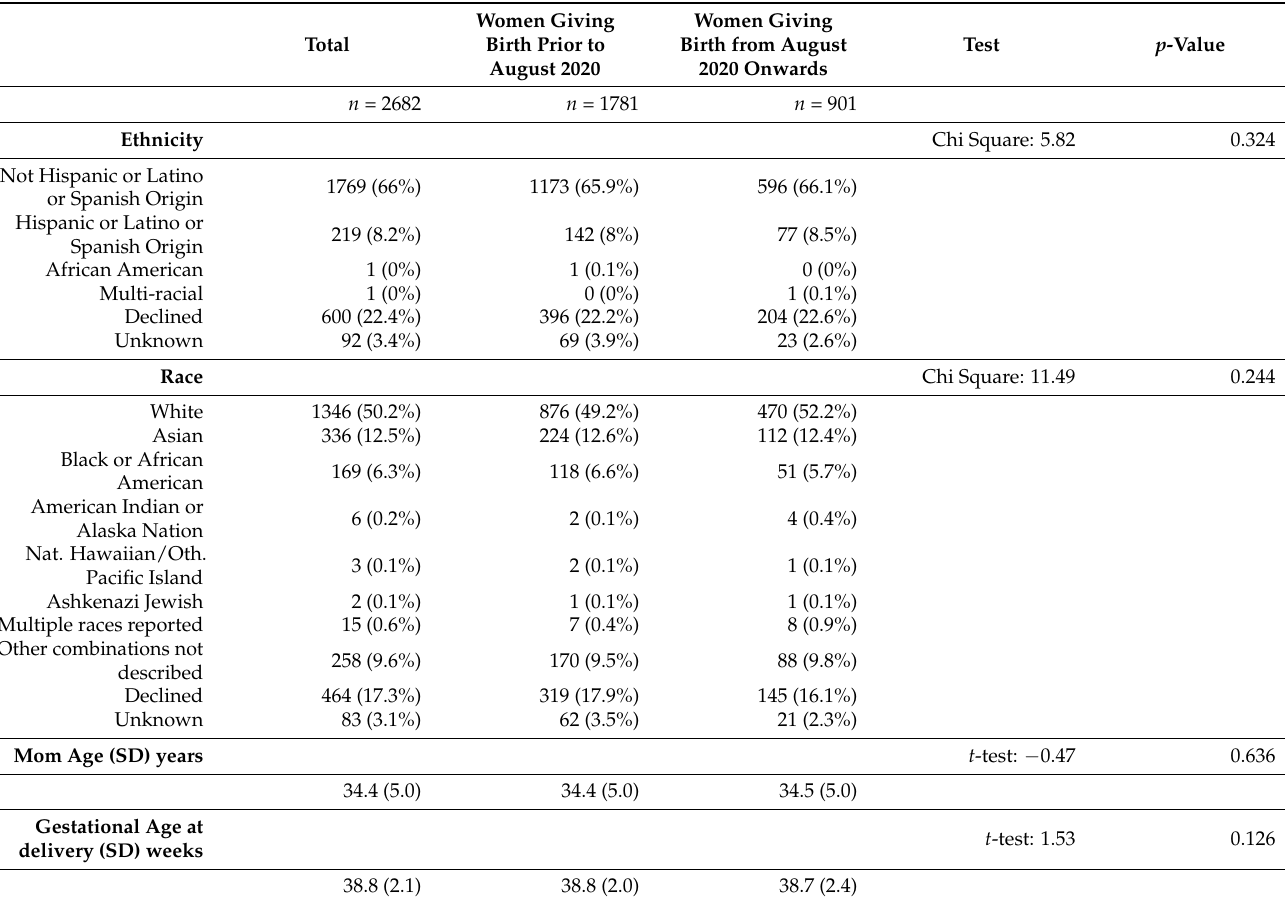
Table 1. Demographics table for women who giving birth prior to August 2020 and from August 2020